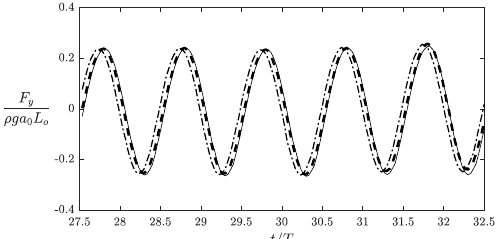
Figure 12. Time histories of dimensionless vertical force acting on the bottom of a surface obsta- cle. Solid line: d m = 0 (solid bottom). Dashed line: d m = δ m . Dashed-dotted line: d m = 3 δ m . The dimensional force F y is given in (5). See Figure 8 for other model